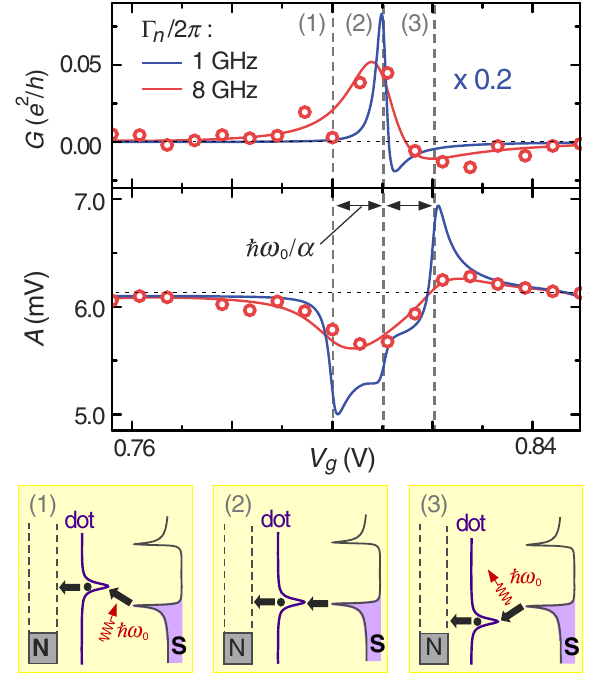
FIG. 5. Conductance G and microwave amplitude A versus V g (red dots), measured along the dashed line in Fig. 4(a) for 0 . 336 mV, and theory using the same parameters as in V b ¼ = 2 π ¼ 8 GHz (red lines) or Γ = 2 π ¼ 1 GHz (blue Fig. 4 and Γ n n = 2 π ¼ 1 GHz has been multiplied lines). The theoretical G for Γ n by 0.2. Panels (1), (2), and (3) illustrate the transport regimes corresponding to the gray dashed lines. In panel (2), the dot orbital is resonant with a BCS peak in the DOS of the S reservoir. In panels (1) and (3), an electron can pass from the dot orbital to a BCS peak by absorbing or emitting a cavity